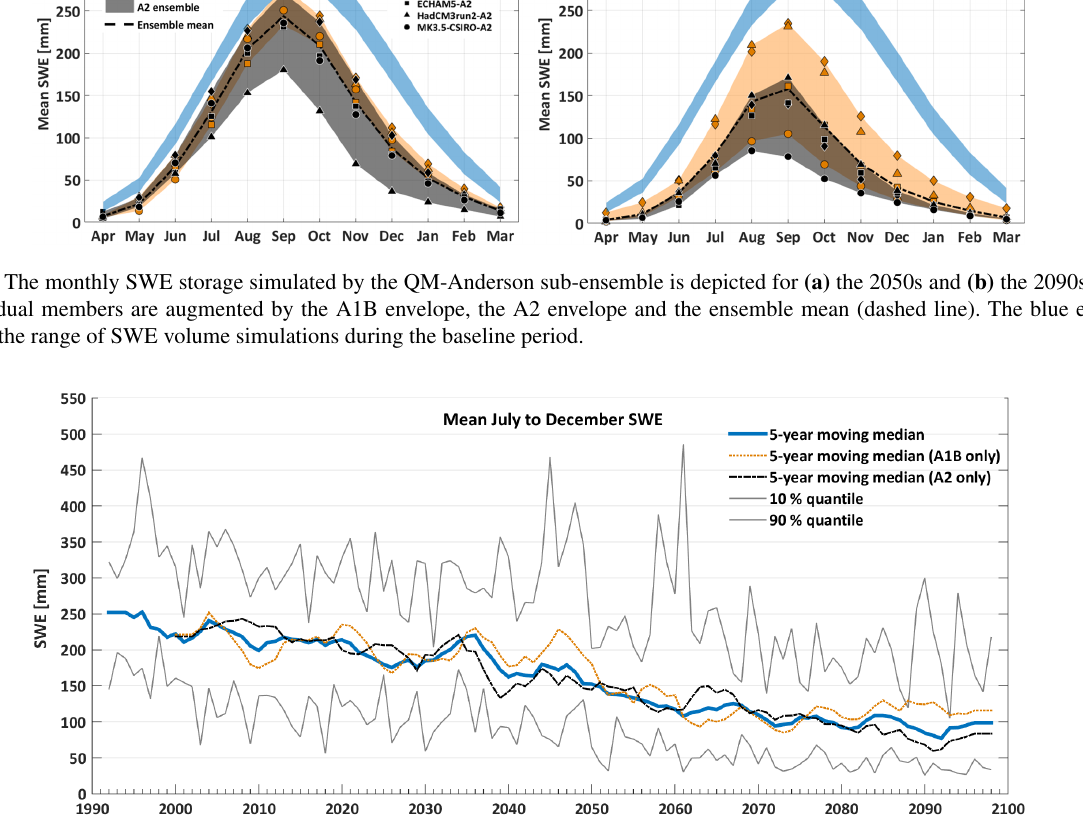
Figure 11. The mean SWE of the 6 months with the historically highest SWE (July to December) is shown for the 16 transient QM simulations (including QM-Anderson and